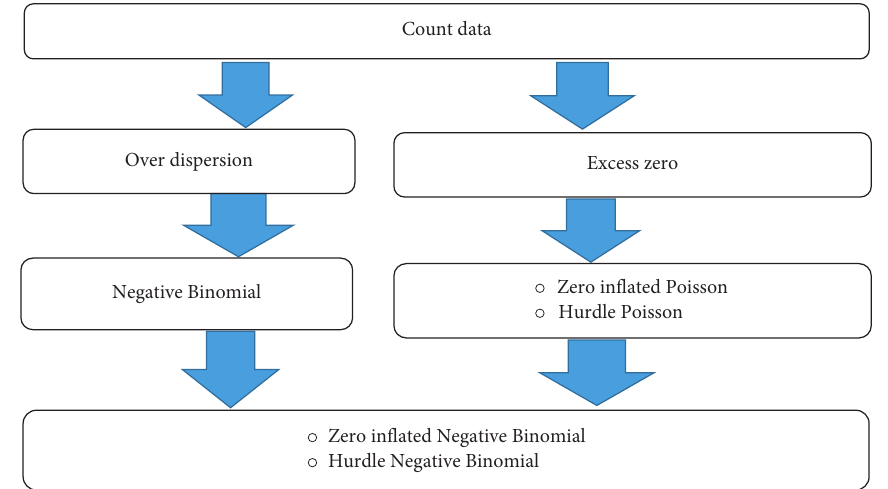
Figure 1: Conceptual framework for count regression